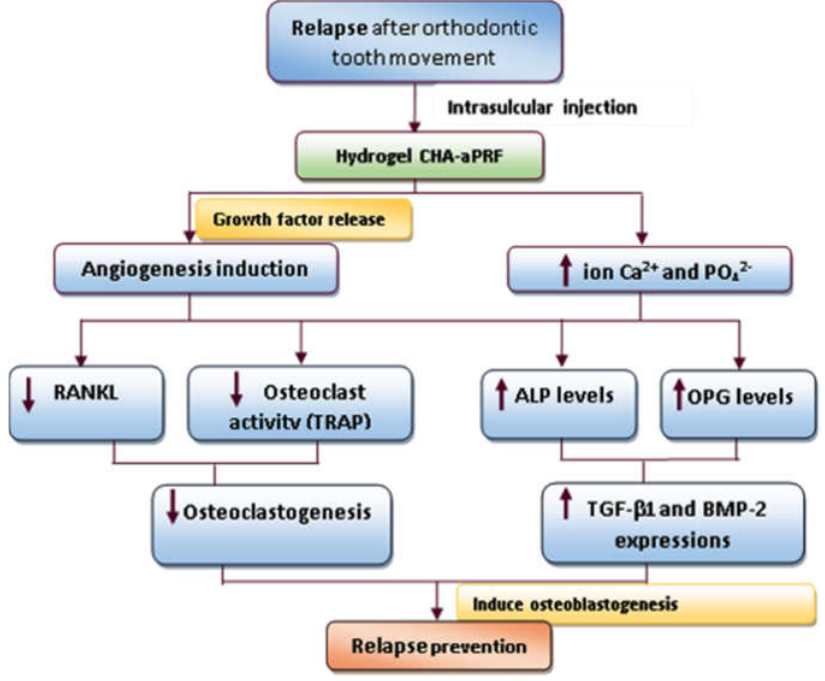
Figure 2. The mechanism of how hydrogel CHA−aPRF works to prevent orthodontic relapse.